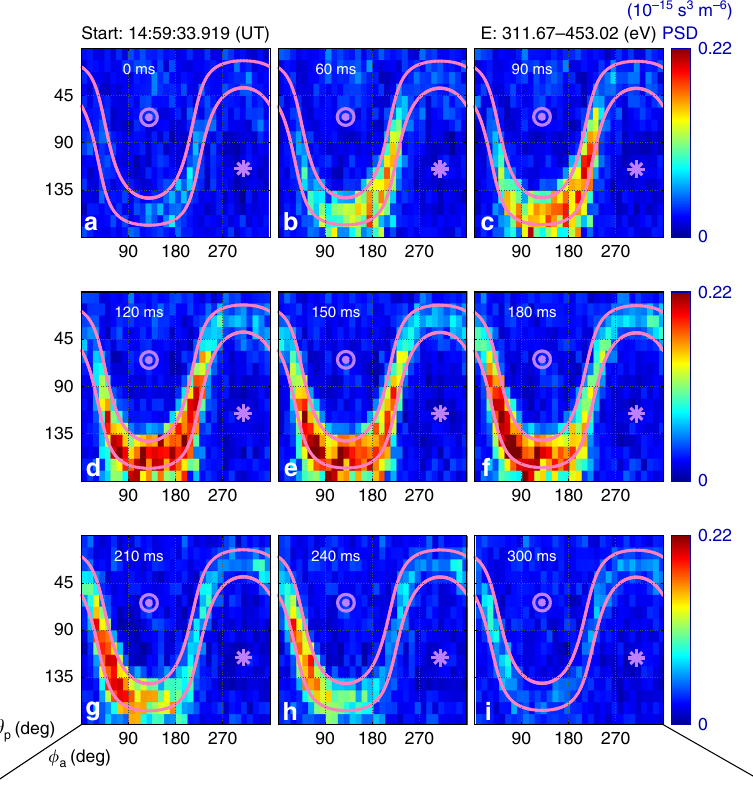
Fig. 2 Sky-maps of electron PSD from MMS3 for one energy channel. Panels a – i show observations at different times. For each panel the horizontal and vertical axes are azimuthal ( ϕ a , degrees) and polar angles ( θ p , degrees), respectively. The measuring time is labeled at the top of each panel, starting from 14:59:33.919 UT. Magenta lines represent the local loss cone. The asterisk and the circle mark directions parallel and anti-parallel to the magnetic fi eld, respectively. The energy channel is labeled in the top right corner of the fi gure. All panels share the same color